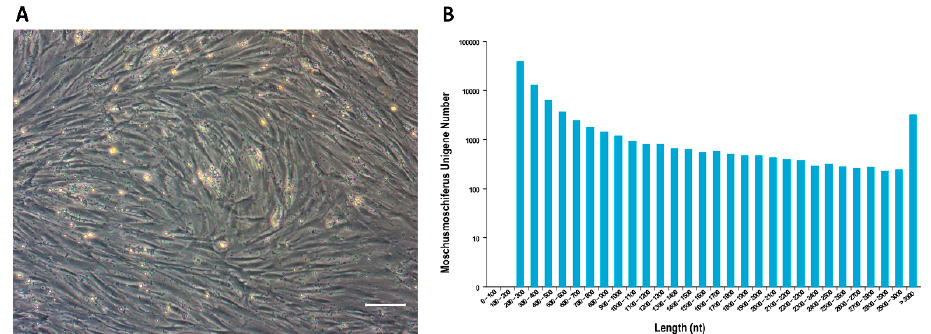
Figure 1. ( A ) Cell morphology of MSCs in vitro cultured at 3 passages. Cells exhibited spindle and fusiform shapes. Scale bar: 100 µm; ( B ) Unigenes length distribution after transcriptome sequencing and de novo assemble. The x-axis represents the length of unigenes, and the y-axis represents the number of unigenes within a certain length range.